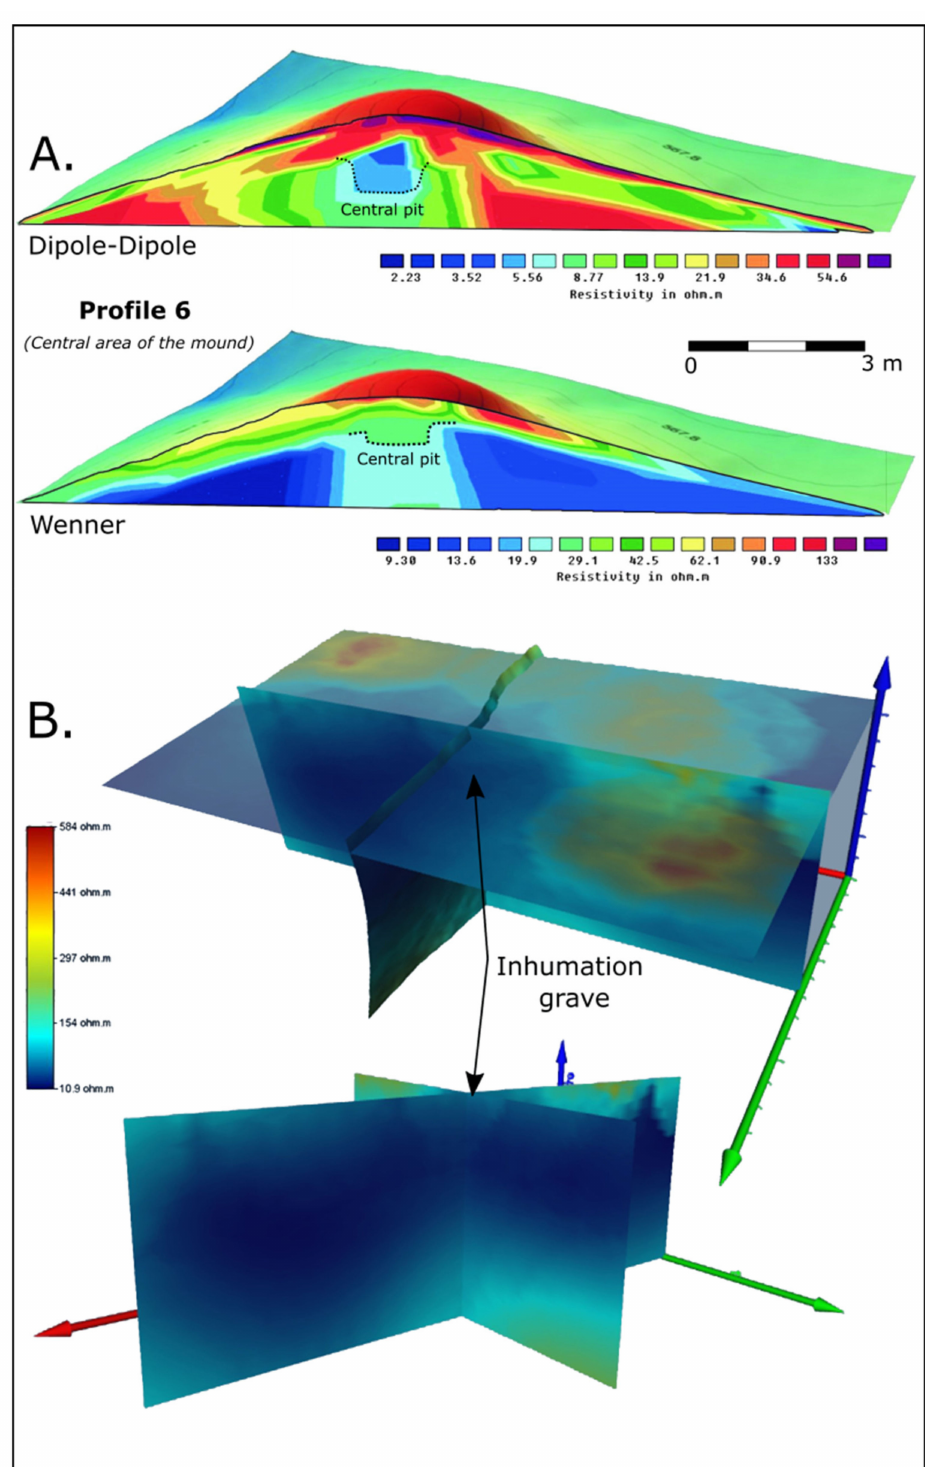
Figure 11. ERT results: ( A ) Profile 6 (Wenner and Dipole–Dipole) passing the center of the mound and close to the northern side of the archaeological excavation; ( B ) Cross-sections extracted from the ERT 3D model (a grave pit is faintly visible in the center of the mound, later the excavation confirmed the existence of an inhumation